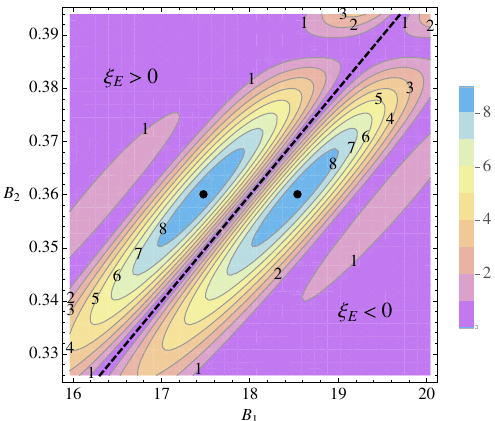
¯ b ð k Þj % for a ¼ 50 th harmonic of 260 nm lasers FIG. 1. j n;m E E with n ¼ − 1 and A 1 ; 2 ¼ 3 . The dashed line is ξ E ¼ 0 , and the ξ ¼ (cid:2) 1 = 2 optima (dots) lie at the centers of the bunching E peaks in their respective regions, with a difference in dispersion Δ B ¼ − 2 ξ =n 1 E